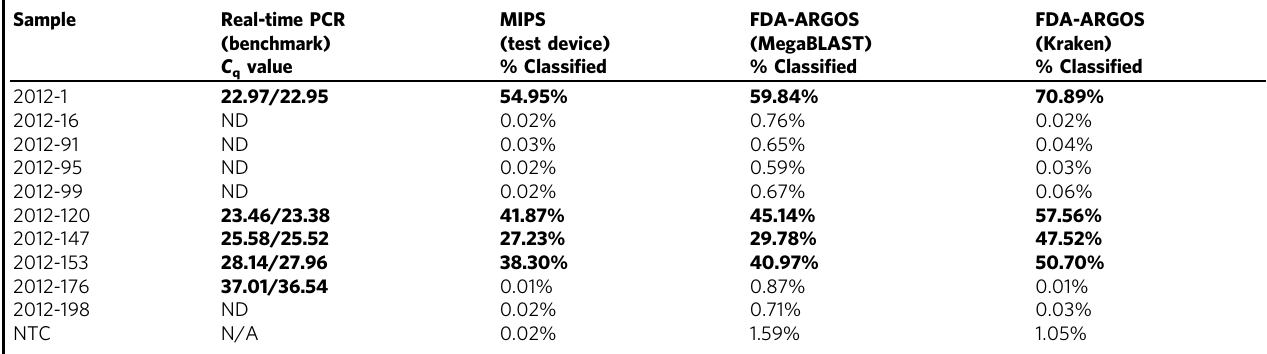
Table 1 Bundibugyo ebolavirus performance summary Sample